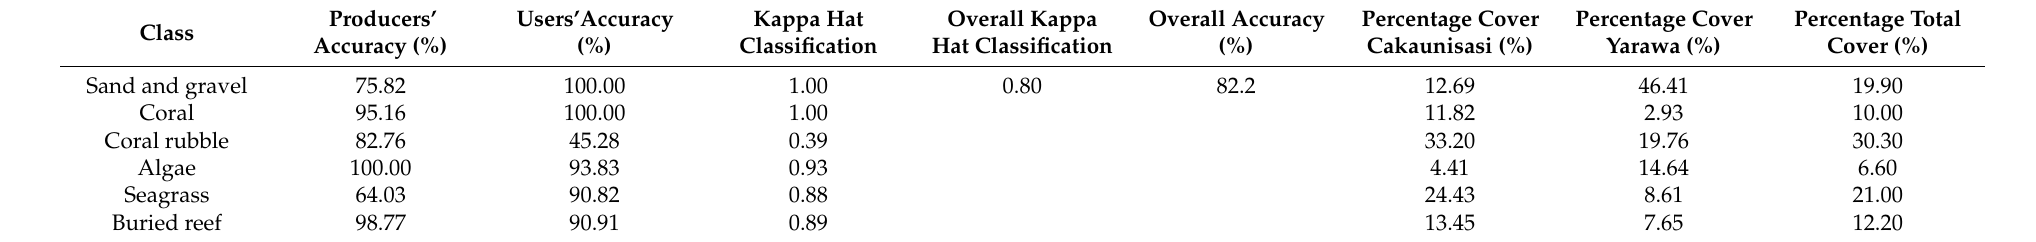
Table 1. The accuracy assessment and results of the confusion matrix for the six benthic cover class types, including the overall accuracy and kappa coefficient for the benthic cover maps of the two reefs of the Votua reef system in the Ba region of Fiji.